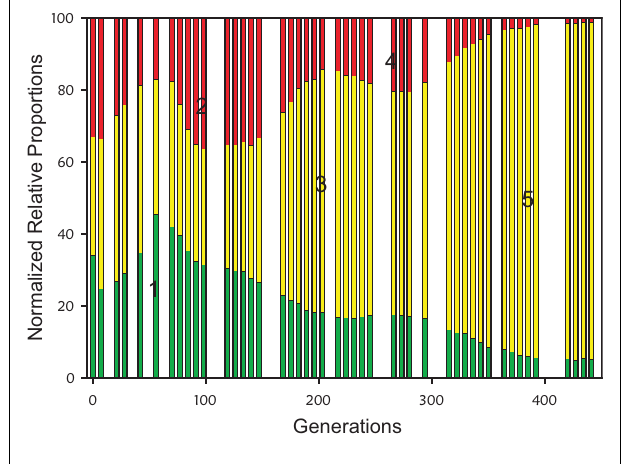
FIGURE 3 | Example population dynamics from a three-coloredVERT system (adapted from Kao and Sherlock, 2008). The colored bars represent the relative proportions of each colored subpopulation. An increase in the relative proportion of a colored subpopulation is indicative of the occurrence and expansion of an adaptive mutation in that subpopulation, and is defined as an adaptive event. Under the assumption that the adaptive mutant responsible for the specific adaptive event is at its’ highest proportion at the end of the sustained expansion, the adaptive mutants are isolated from the expanding subpopulation from the generation at the end of each expansion.The generation and colored subpopulation from which adaptive mutants were isolated are numbered